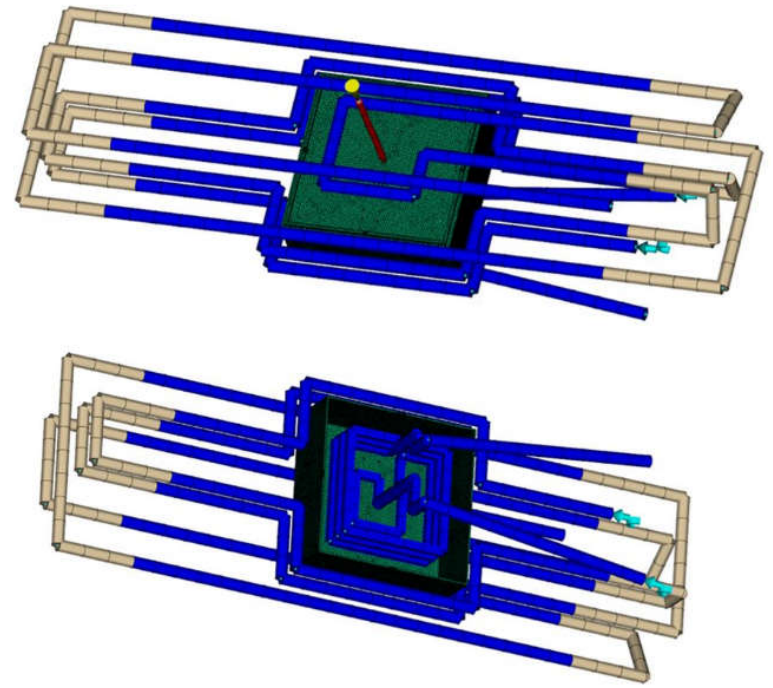
Figure 2. Simulation model with part (green), cooling system (blue/gray) and hot runner (red).